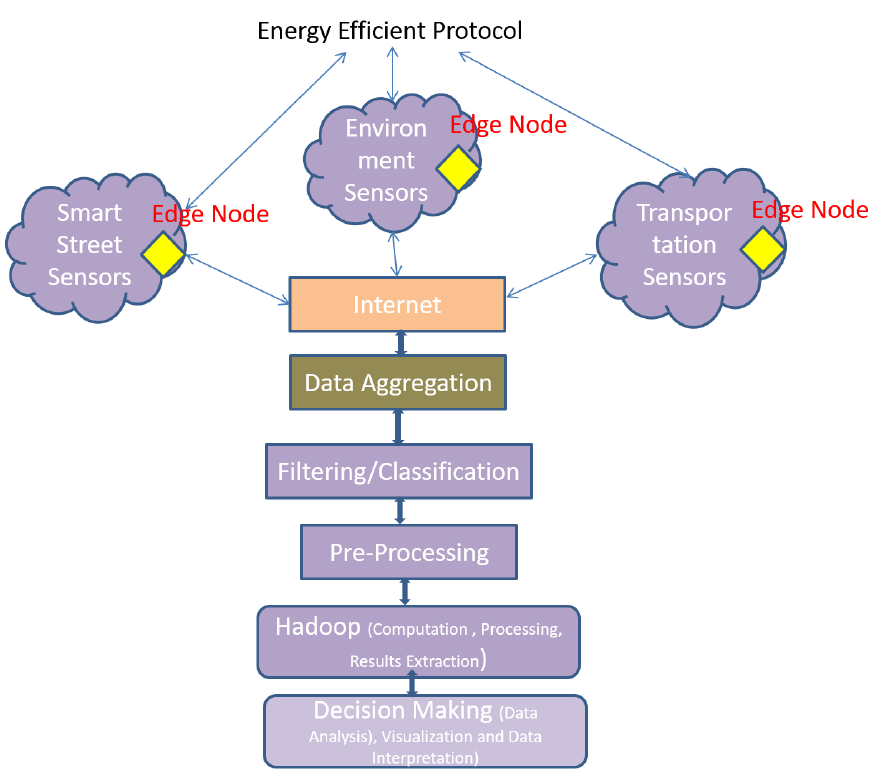
Figure 2. Implementation